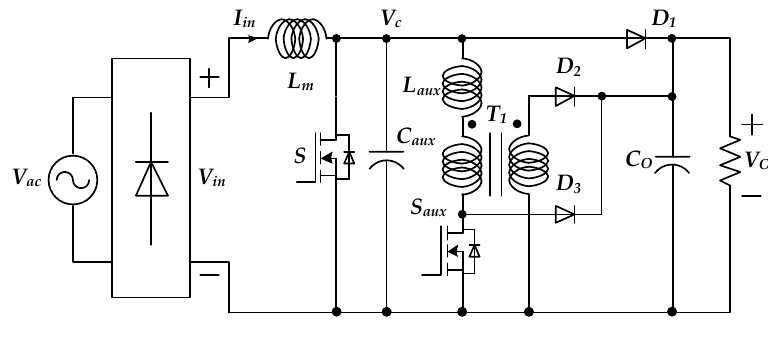
Figure 1. Proposed tandem boost PFC